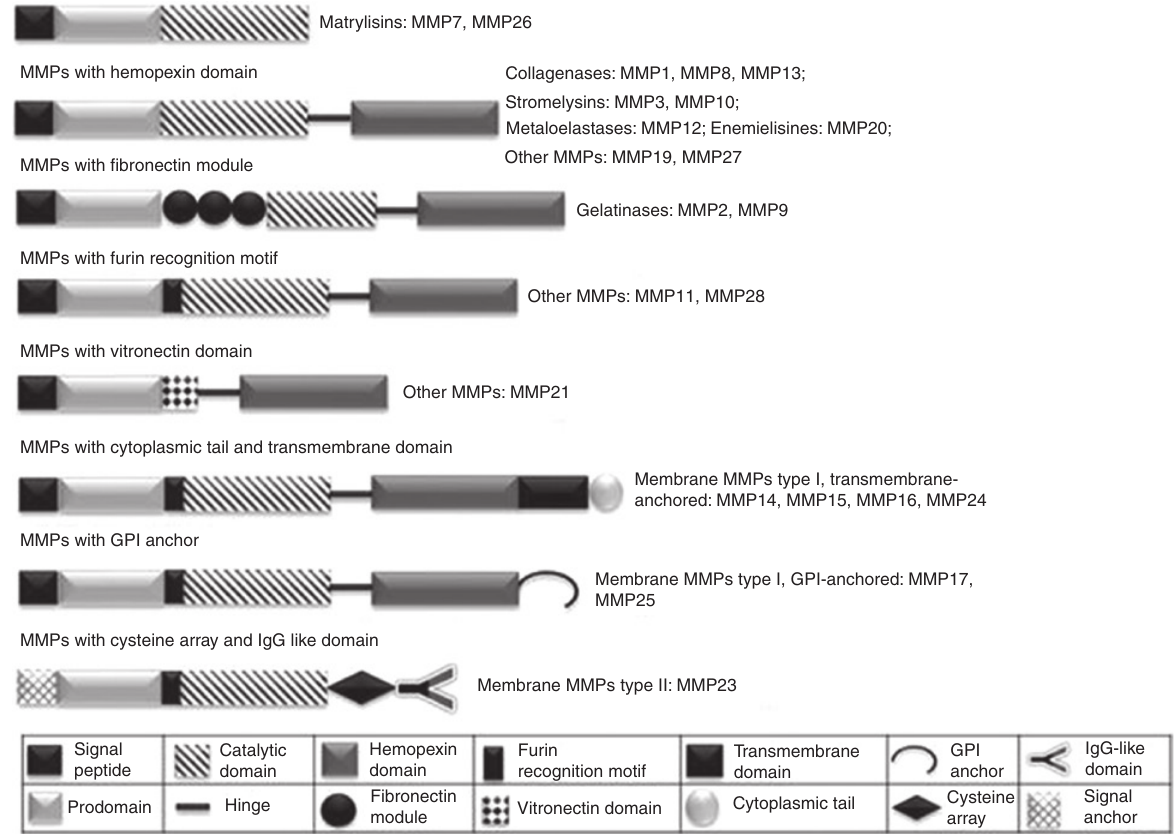
Figure 1: Domain structure of metalloproteinases (own